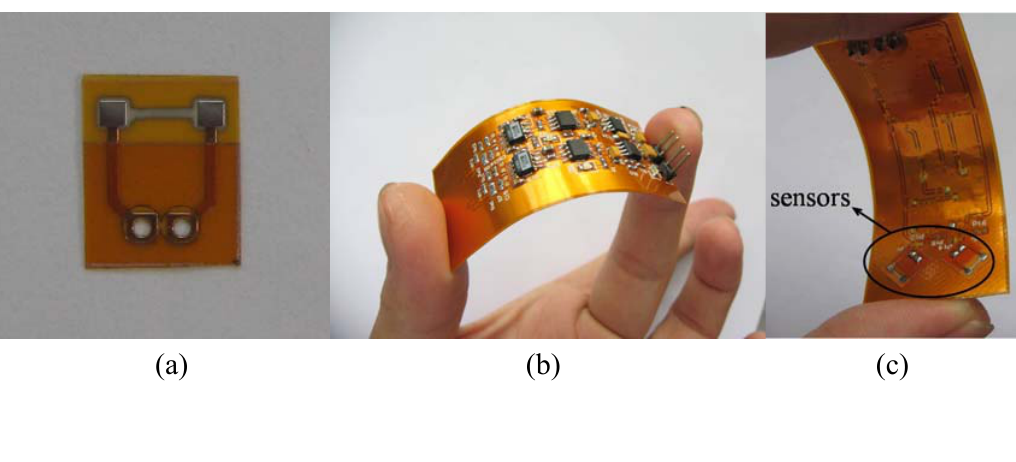
Figure 2. Sensors with signal conditioning circuit: (a) a sensor unit (7 × 8 × 0.02 mm); (b) the reverse side of a measurement system with the circuit (20 × 60 × 1 mm); (c) the front side of the system with two